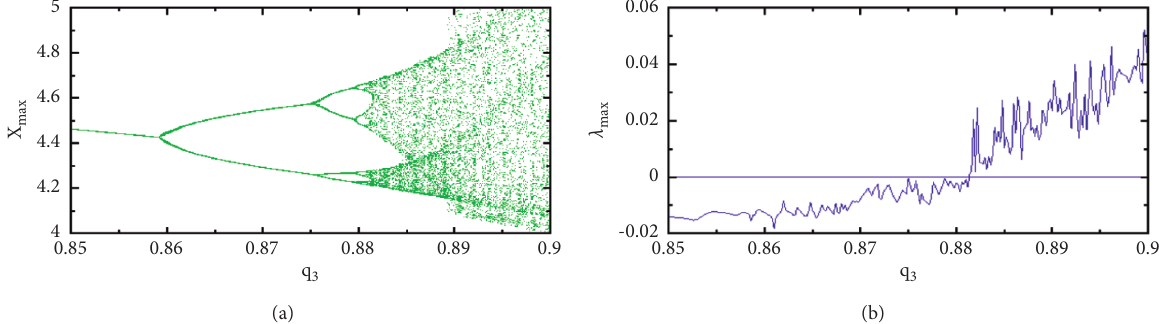
Figure 7: Phase diagrams of system (6) with fractional orders q (b) the x − z phase plane.